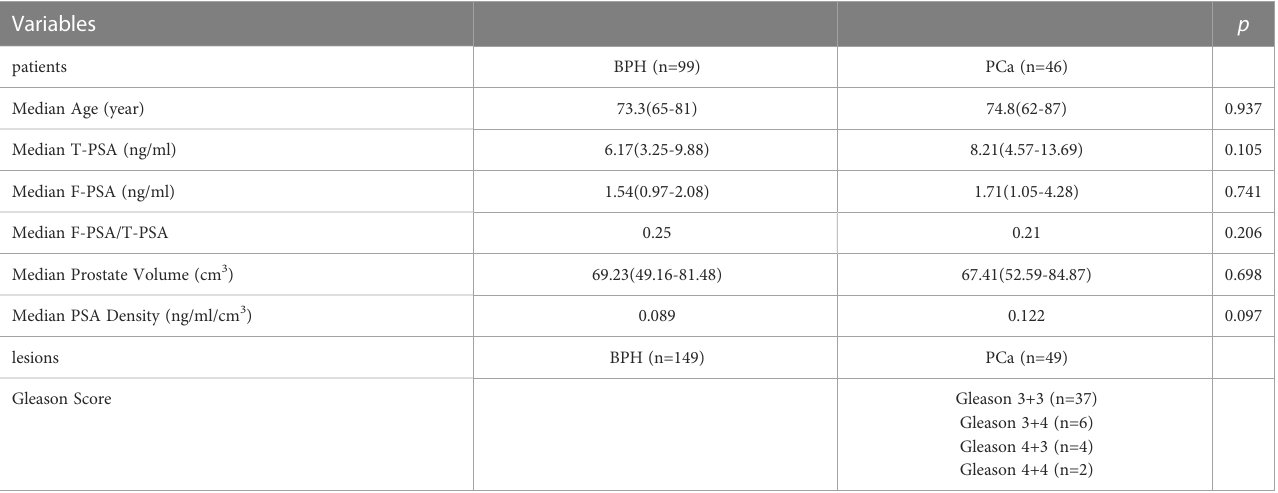
TABLE 3 Clinical characteristics of the patients and lesions.